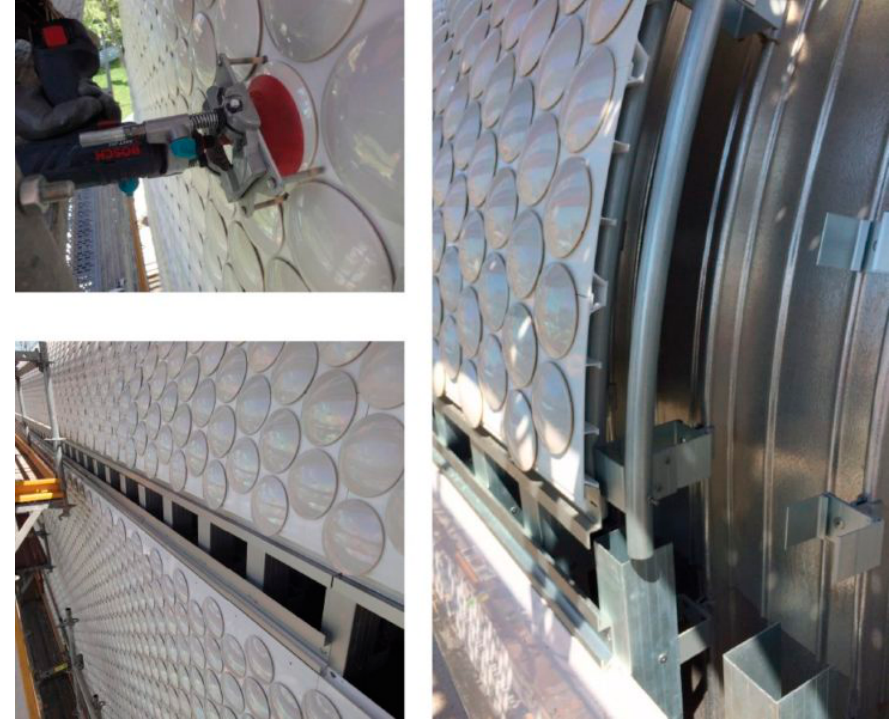
Figure 3. Ceramic tile laying system. Tect ó nica. RPBW. Disset. http: // tectonicablog.com / wp-content / uploads / 2017 / 03 /